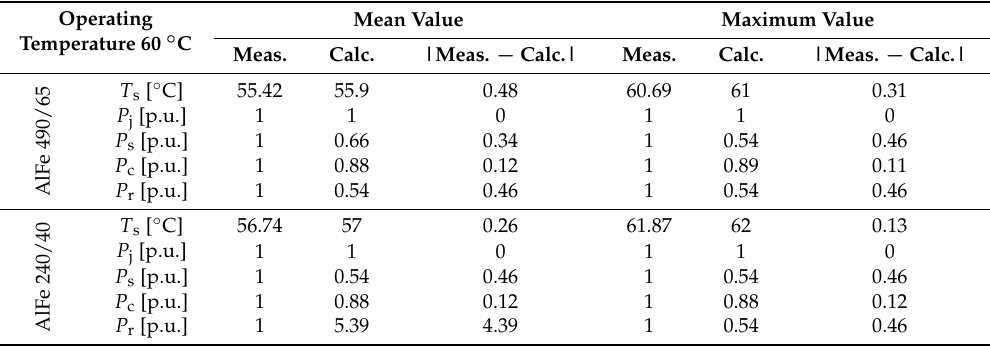
Table 2. Measured (meas.) and model-calculated (calc.) mean and maximum values of the conductor temperature, heating and cooling powers (per unit values) for the conductor AlFe 490/65 and AlFe 240/40 at operating temperature 60 ◦